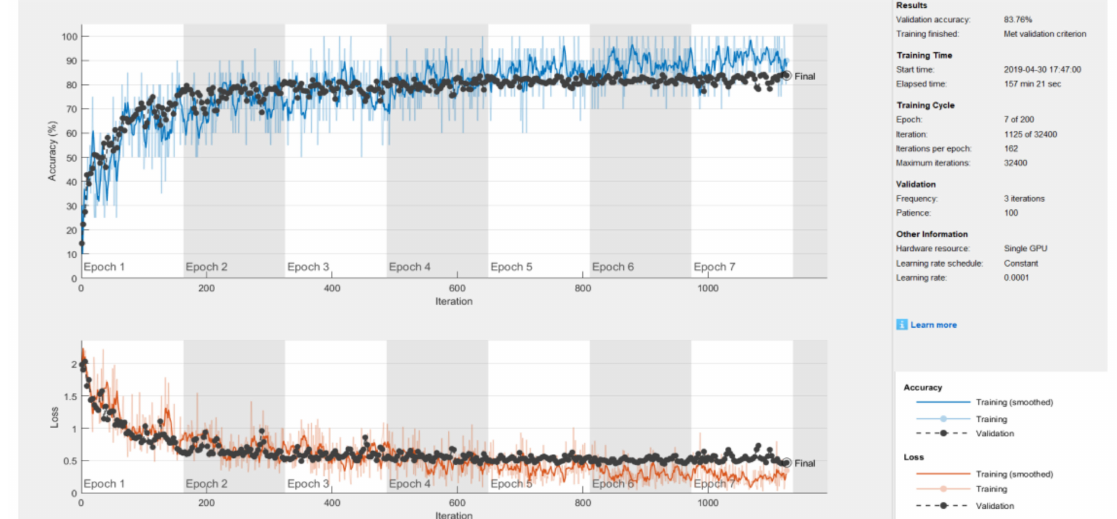
Figure 12. The accuracy and loss of the model.